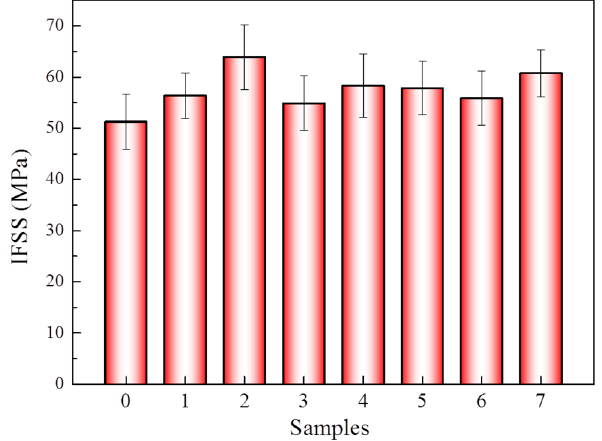
Figure 9. Interfacial shear strength (IFSS) of the aramid / epoxy before and after scCO 2 treatment with 1,4-dichlorobutane under a static tension of 9 N. (0): untreated fiber; (1–7): modified fibers of samples 1–7 in Table 1. At least 20 samples were tested of all specimens. The vertical bars represent the standard deviations.